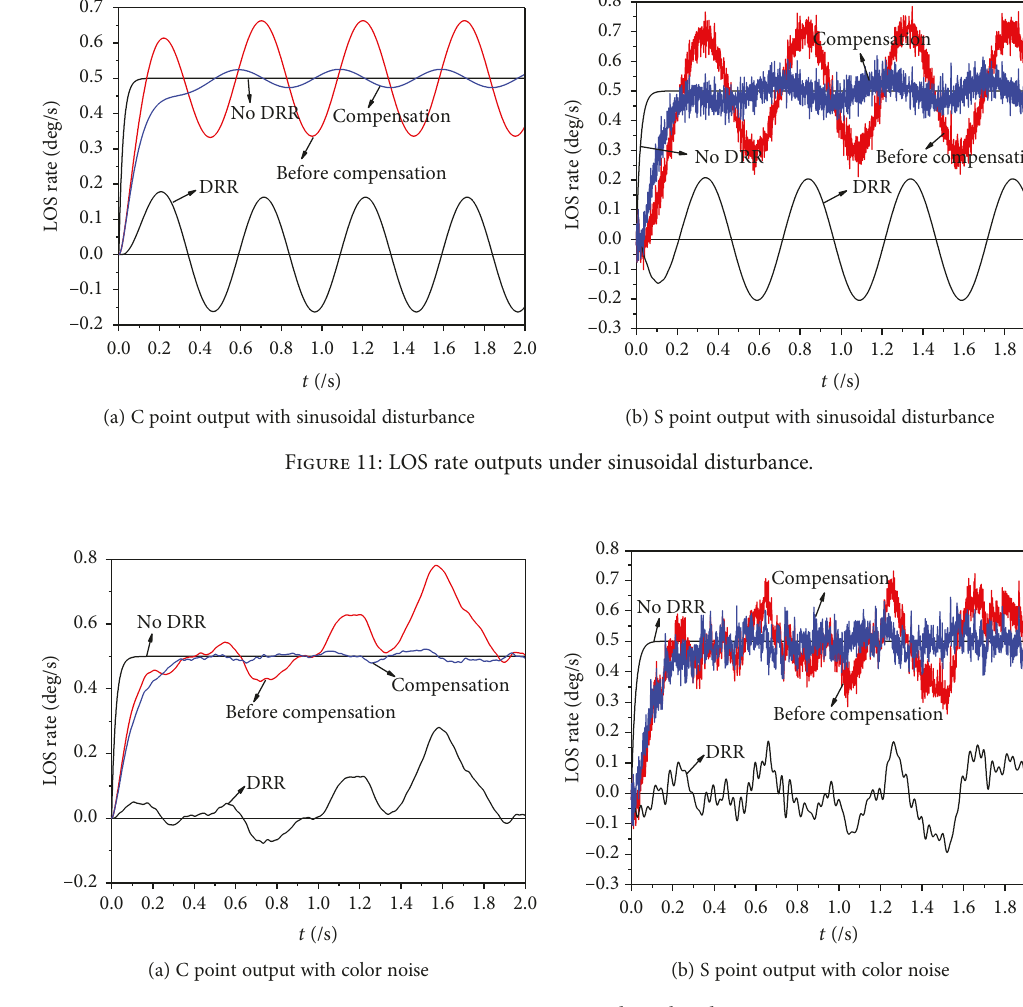
Figure 12: LOS rate outputs under colored